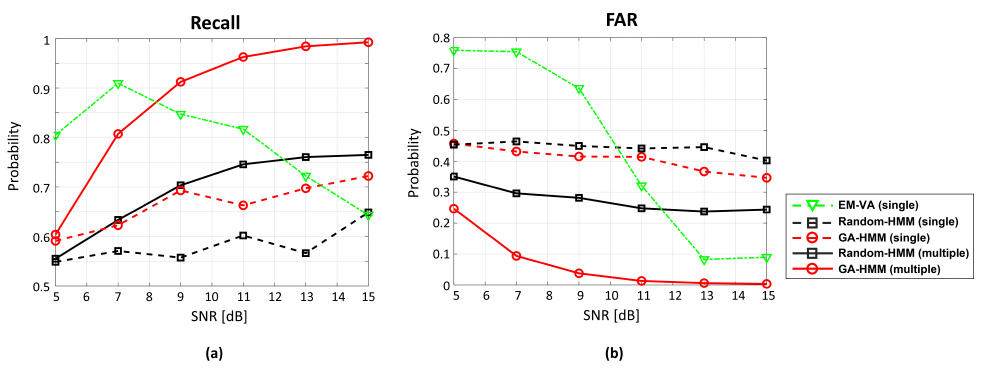
Figure 5. Detection performance of scheme according to SNRs: ( a ) Recall; ( b ) FAR. Multiple measure- ments consist of 30 synthetic